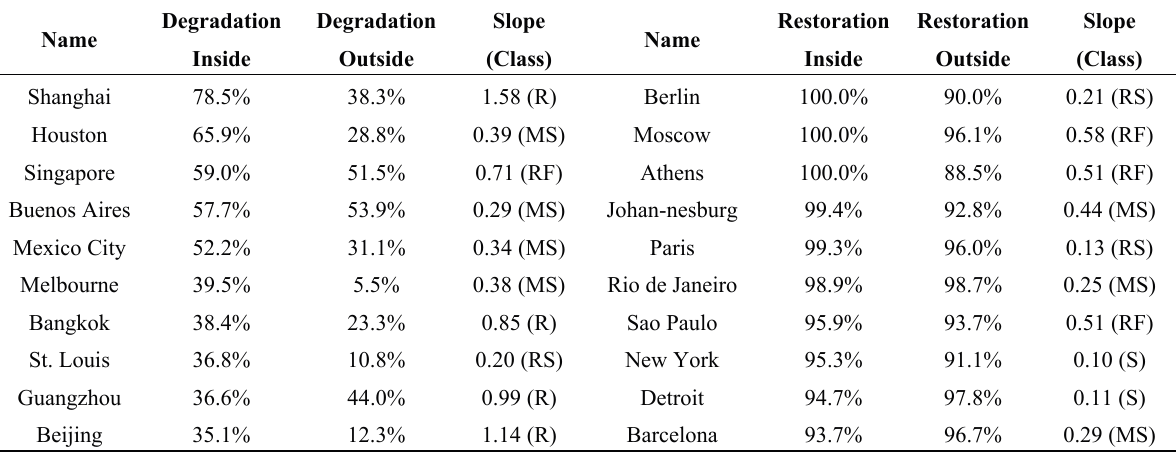
Table 6. The top 10 cities with the highest variation percentages in the urbanization area and the comparison of outside buffers from 2001 to 2010. Dubai is the unique city with mean NDVI <